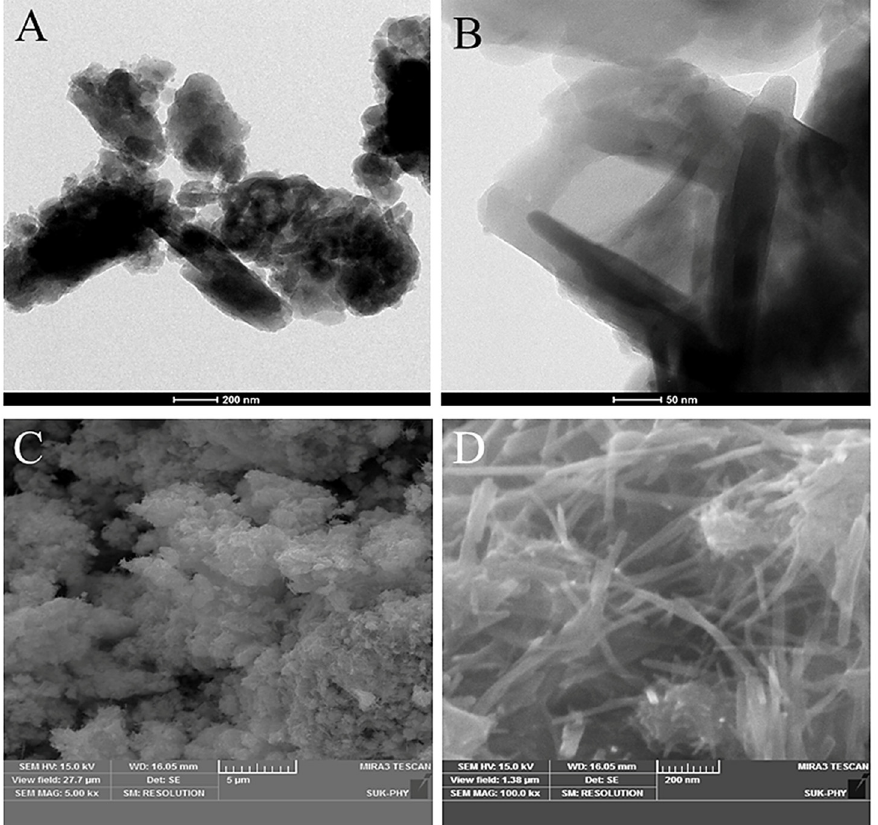
Figure 2. ( A , B ) TEM images of α -MnO 2 -PANI composites at di ff erent magni fi cations. ( C , D ) FESEM images of the composites at di ff erent magni fi cations.